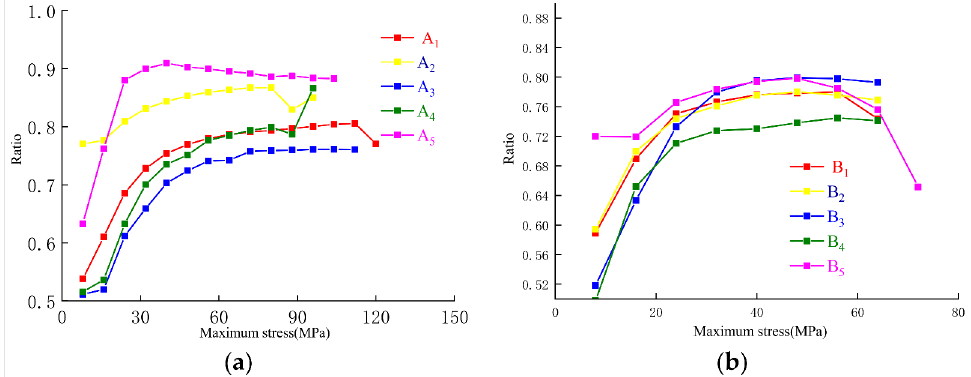
Figure 6. Elastic strain energy ratio during cyclic loading and unloading of sandstone. ( a ) Dry rock samples. ( b ) Saturated rock samples.